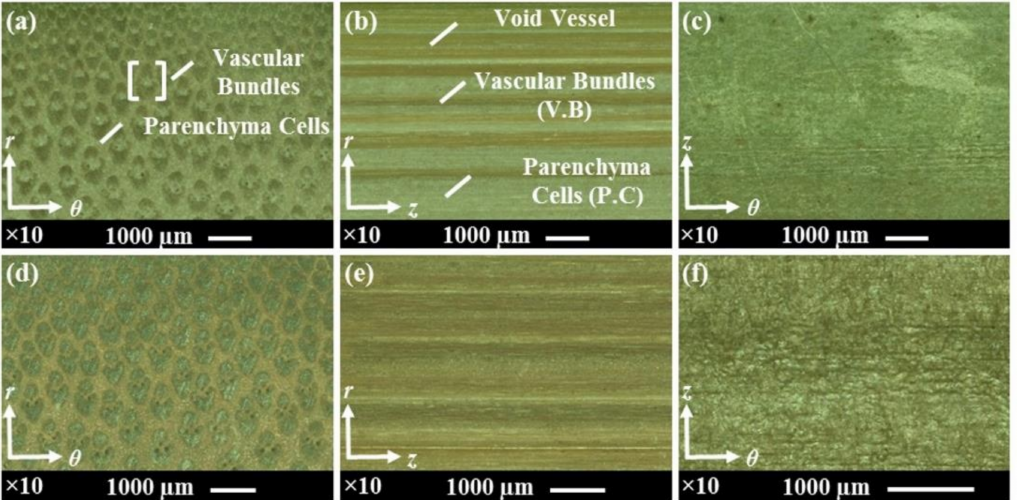
Figure 6. Laser micrographs of radial-tangential, longitudinal-radial and longitudinal-tangential surfaces of: ( a – c ) untreated bamboo and ( d – f ) smoked